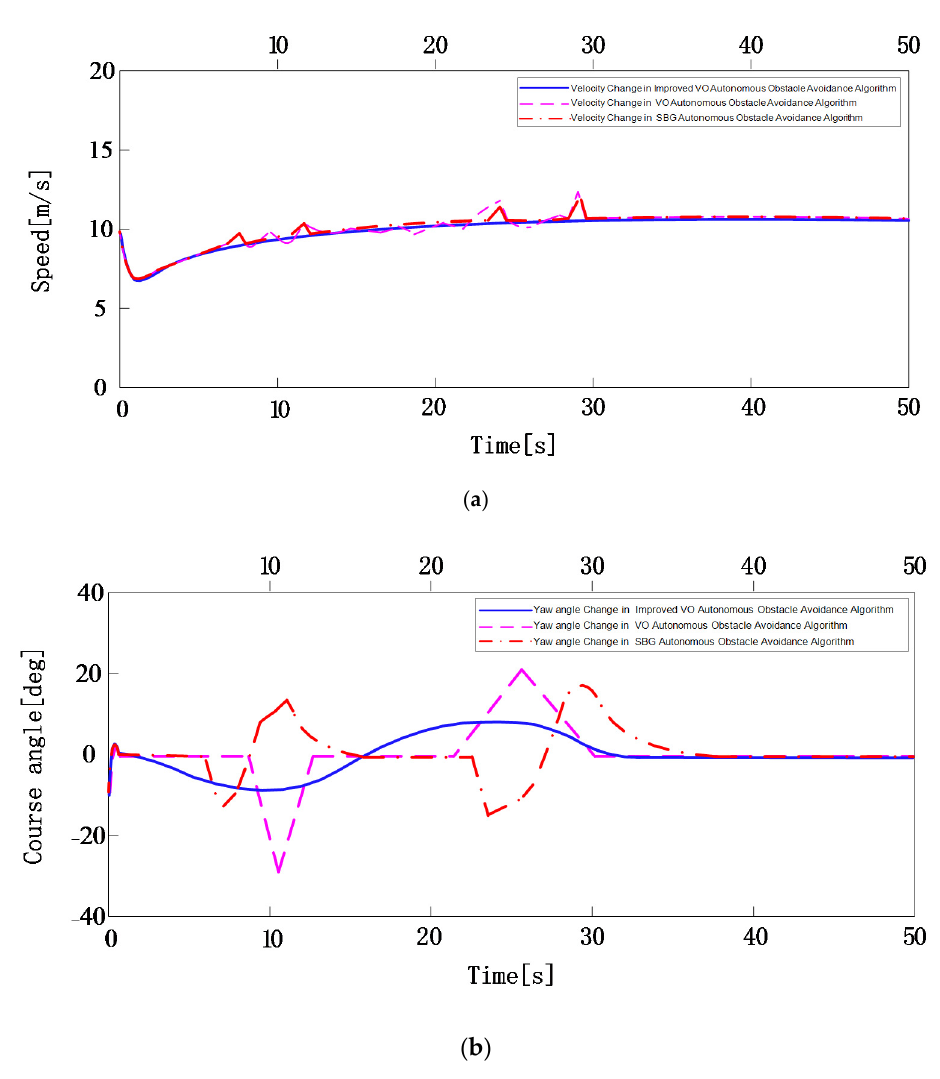
Figure 15. The schematic diagrams of USV velocity and yaw angle changes during autonomous obstacle avoidance with three algorithms. ( a ) Velocity Change of Autonomous Obstacle Avoidance Algorithm; ( b ) Yaw angle Change of Autonomous Obstacle Avoidance Algorithm.